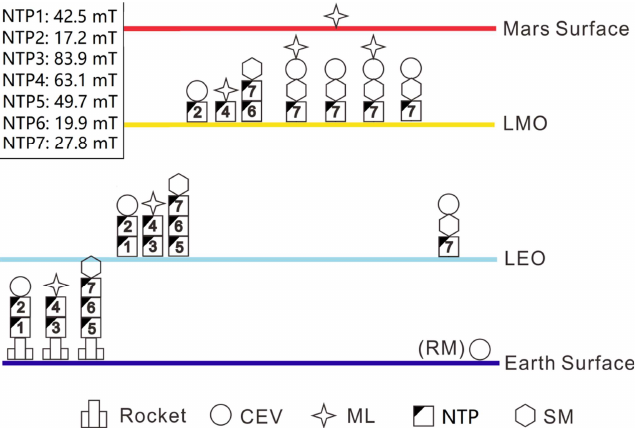
Figure 21. Mission profile of